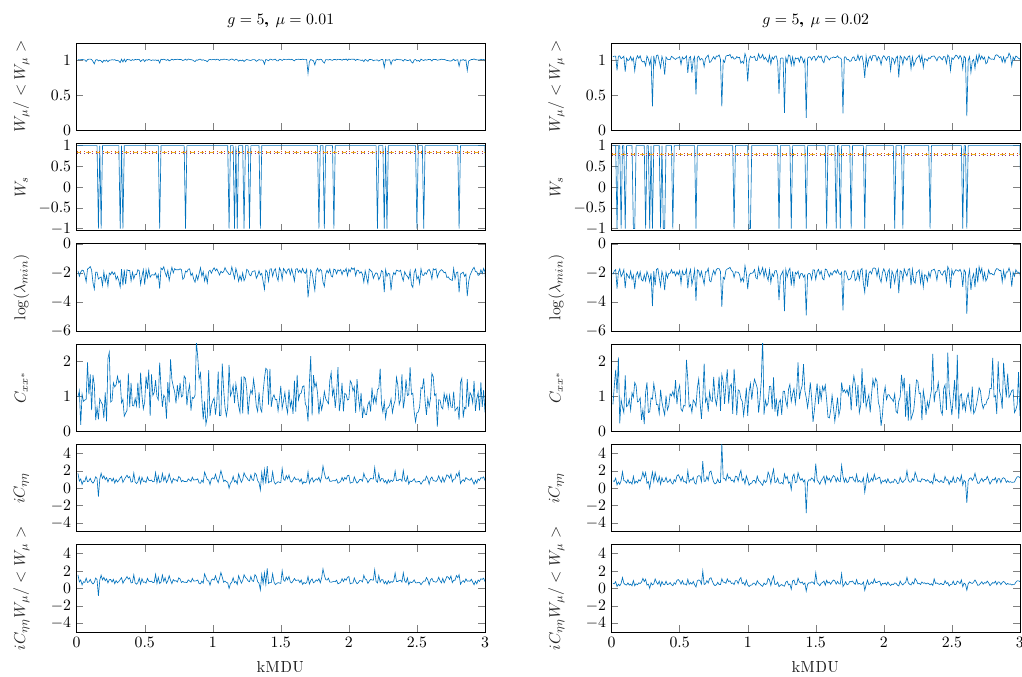
Figure 8 . Time history of the reweighting factors W (cid:22) and W s in (4.3), the bosonic correlator C xx ( t ) and the fermionic correlator C (cid:17)(cid:17) ( t ) on two ensembles with L = 8, g = 5 with two di(cid:11)erent values of the reweighting parameter, (cid:22) = 0 : 01 (left) and (cid:22) = 0 : 02 (right). The correlators are evaluated on a time-slice t = T= 4. The last three lines are normalized, so that they average to 1 (e.g. the third line is actually C xx = C xx ). For larger (cid:22) , zero eigenvalues are more accessible and h i the fermionic correlator develops spikes. The latter are cancelled after reweighting (sixth line). A more quantitative way to see the e(cid:11)ect of reweighting on the observables is a